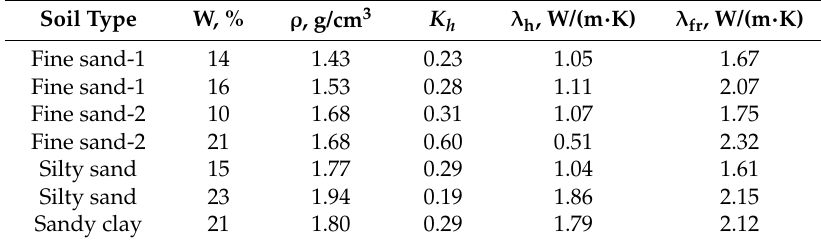
Table 3. Thermal conductivities of frozen soil samples with ( λ h ) and without ( λ fr ) pore methane hydrate (T = − 6 ± 1 ◦ C, P = 0.1 MPa). Soil Type W, % ρ , g/cm 3 K h λ h , W/(m · K) λ fr , W/(m ·